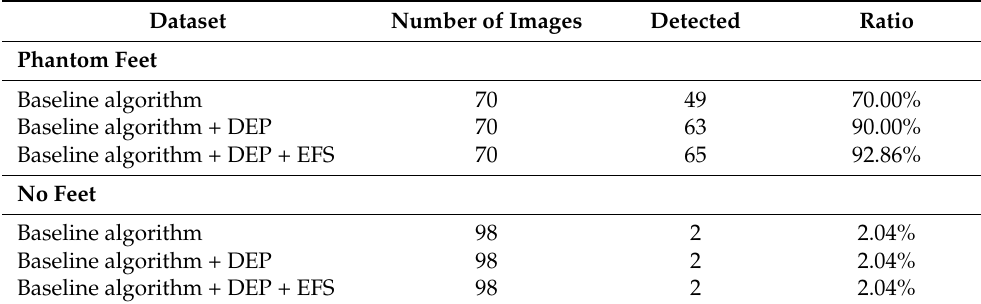
Table 1. Baseline algorithm with DEP and EFS experiment results for feet outline detection.